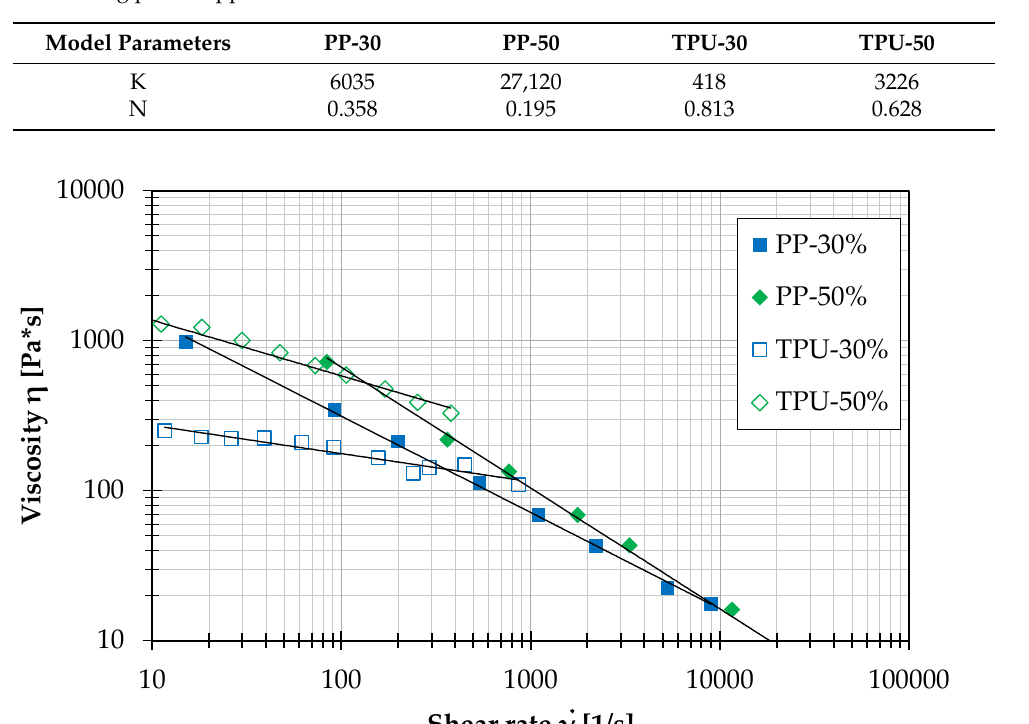
Figure 1. Achievable flow path length over the injection pressure as a function of the matrix material (PP, TPU) and the wood content (30, 40, 50 wt.%), as well as scans of the flow spirals at 140 bar injection pressure. Table 3. Model parameters consistency factor K and flow exponent n from regression of viscosity curve using power approach.